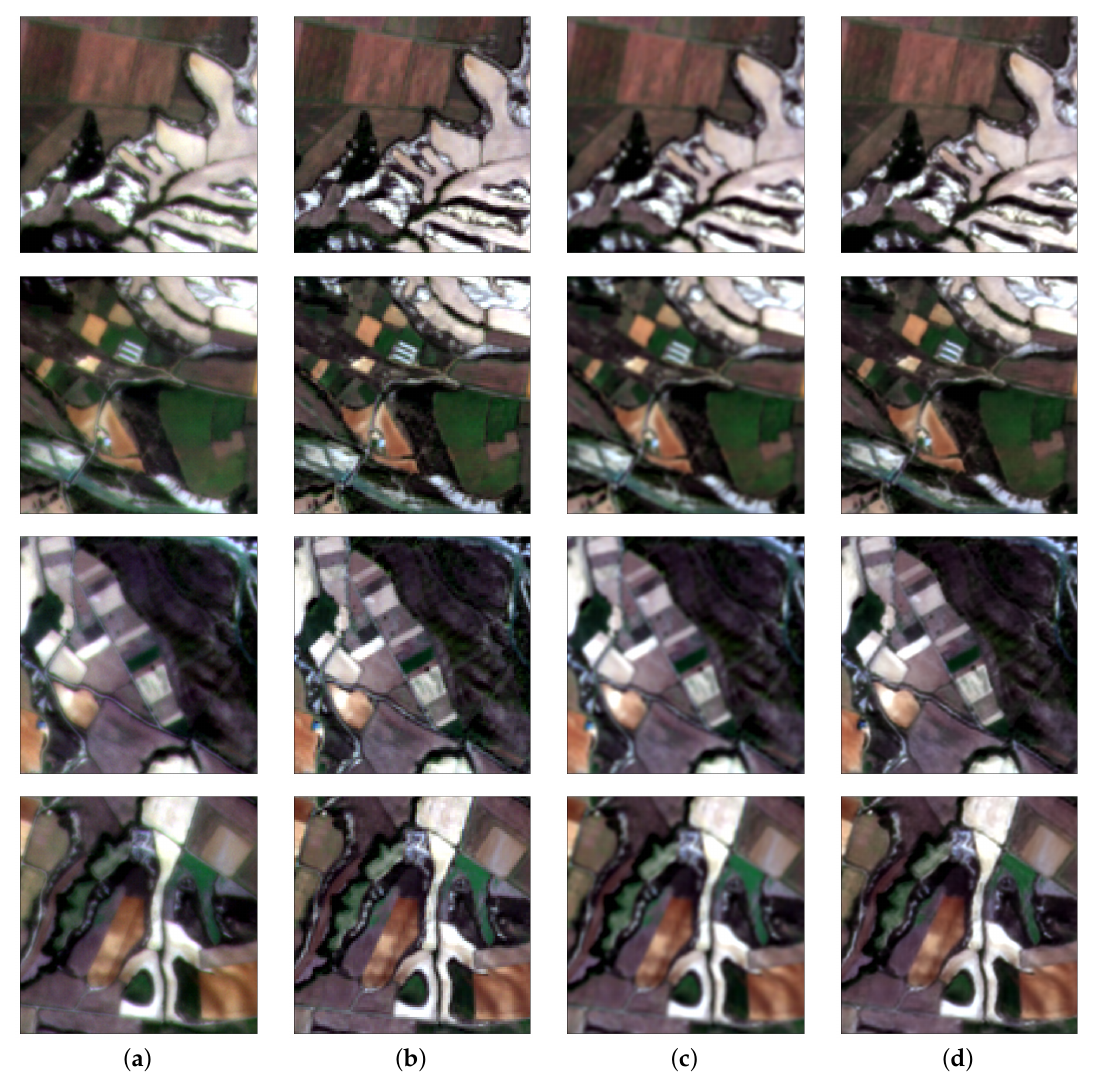
Figure A1. Visual comparison (RGB) between images from the test set. ( a ) HR; ( b ) LR with nearest neighbour interpolation; ( c ) LR with bicubic interpolation; ( d ) SARNet8. The results obtained with SARNet8 are sharper than those obtained with the other